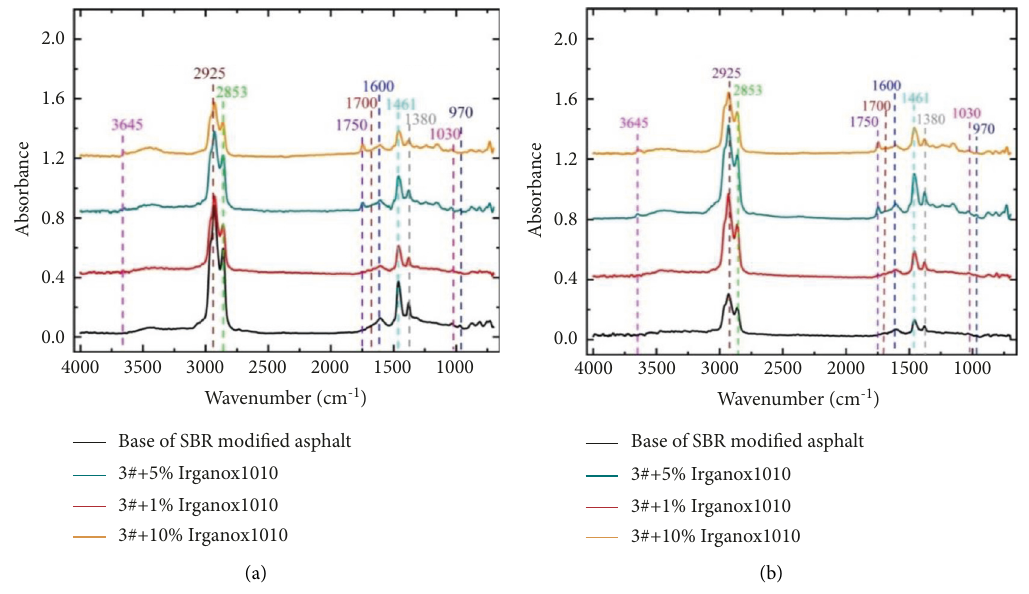
Figure 13: FTIR spectra of asphalt 3# (a) before aging (b) after aging.